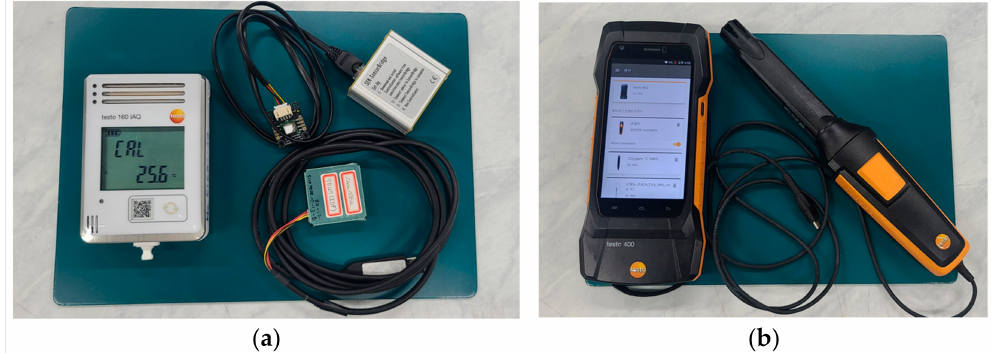
Figure 5. Photos of indoor air quality measuring devices used: ( a ) IAQ160, SCD40, and Sensirion SPS30 for the PM 2.5 concentration and ( b ) Testo 400 for the CO 2